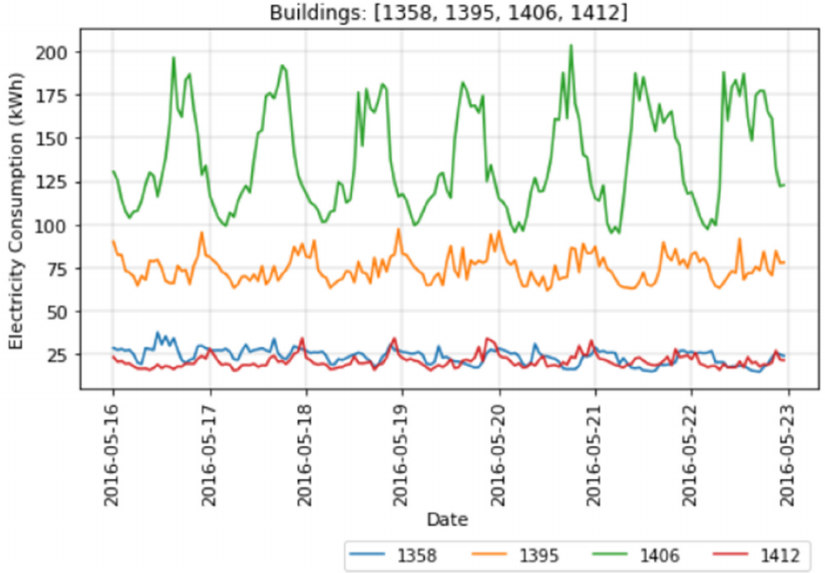
Figure 3. Hourly electricity consumption for buildings 1358, 1395, 1406, 1412 in a generic week of the measuring period, showing variations in scale and